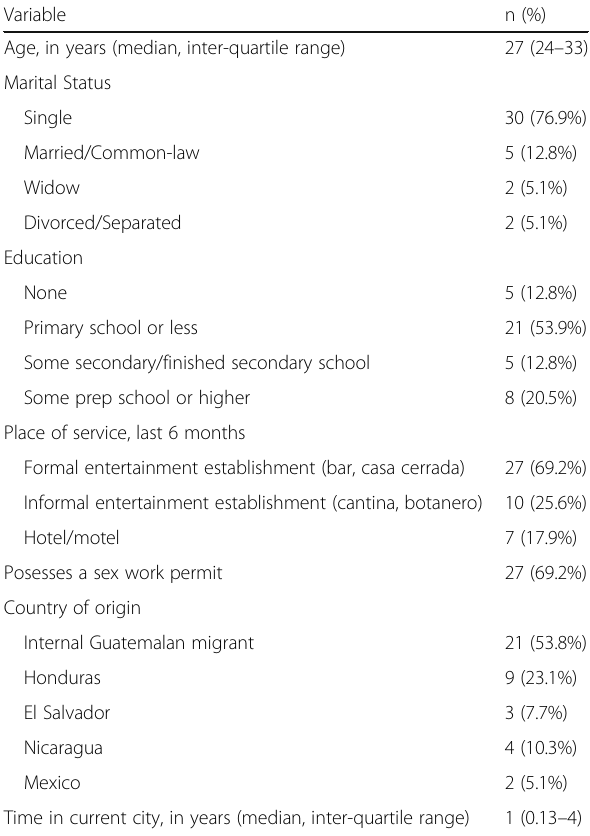
Table 1 Socio-demographic characteristics of migrant